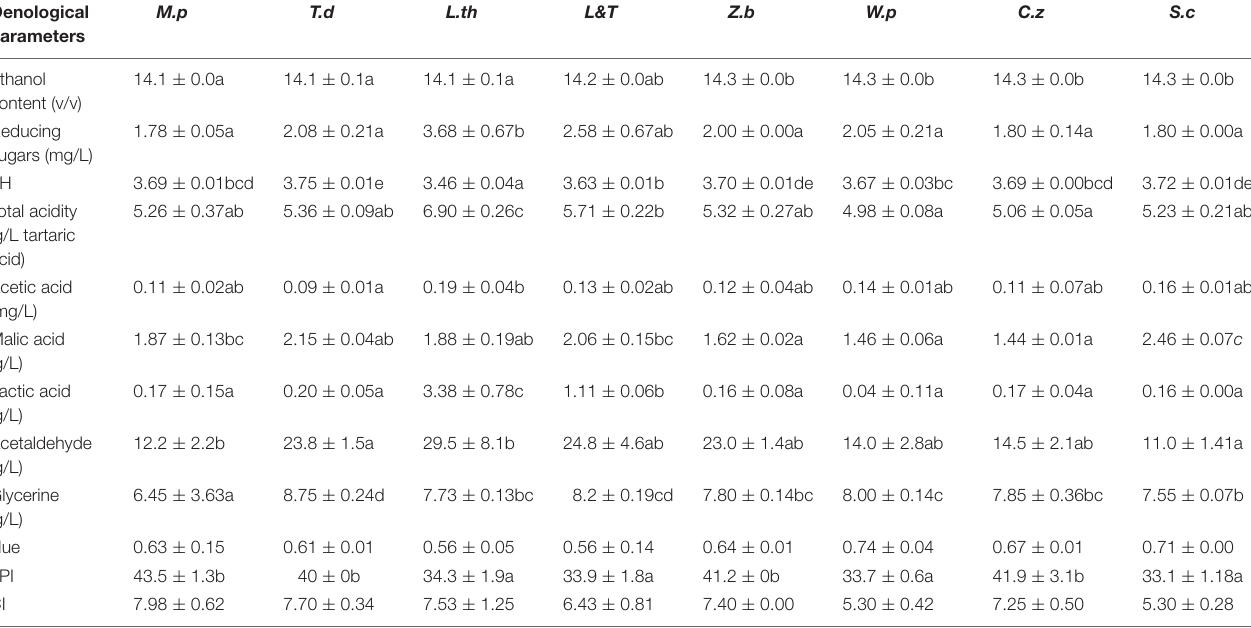
TABLE 1 | Average oenological parameters assessed for wines sequentially tested with non- Saccharomyces species ( M.p, Metschnikowia pulcherrima; T.d, Torulaspora delbrueckii; L.th, Lachancea thermotolerans; L&T, L.th/T.d 30/70; Z.b, Zygosaccharomyces bailii; W.p, Williopsis pratensis; C.z, Candida zeylanoides ) and S.c, Saccharomyces cerevisiae with their standard deviation and results of statistical analysis. Oenological